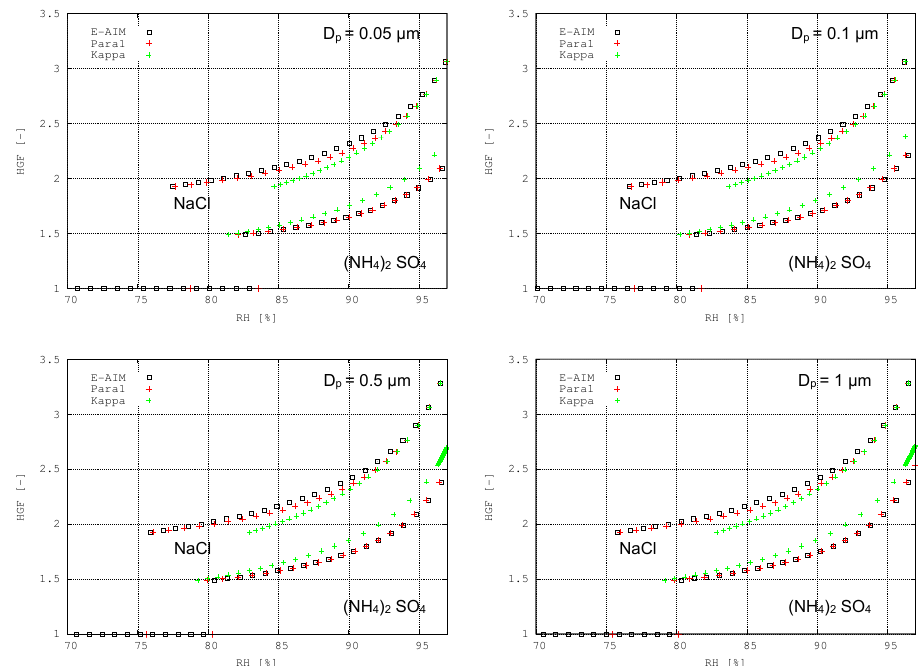
Fig. 3. Same as Fig. 1, but for dry particle diameter D s = 0 . 05 (upper left), D s = 0 . 1 (upper right), D s = 0 . 5 (lower left) and D s = 1 [ µm ] (lower right) comparing E-AIM with Para1 of Table 1 for RH ≤ 97 [ % ] . For comparison, the results using the κ method of Petters and Kreidenweis (2007) are also included, labeled Kappa, obtained by solving Eq. (A30) of Rose08 using κ = 1 . 28 for NaCl ( cr ) and κ = 0 . 61 for ( NH 4 ) 2 SO 4 ( cr ) . Note that it is not possible to obtain HGF results below to the RHD for NaCl ( cr ) with the κ -method using κ = 1 . 28.